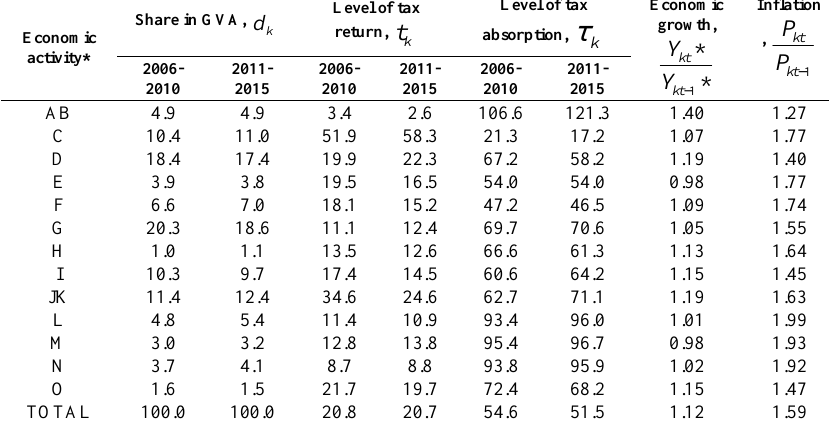
Table 1. The dynamics of indicators of the regional tax sphere and factors influencing them disaggregated by main economic activities (%) Level of tax Economic Level of tax Share in GVA, d t growth, t return, k absorption, k Economic k activity*